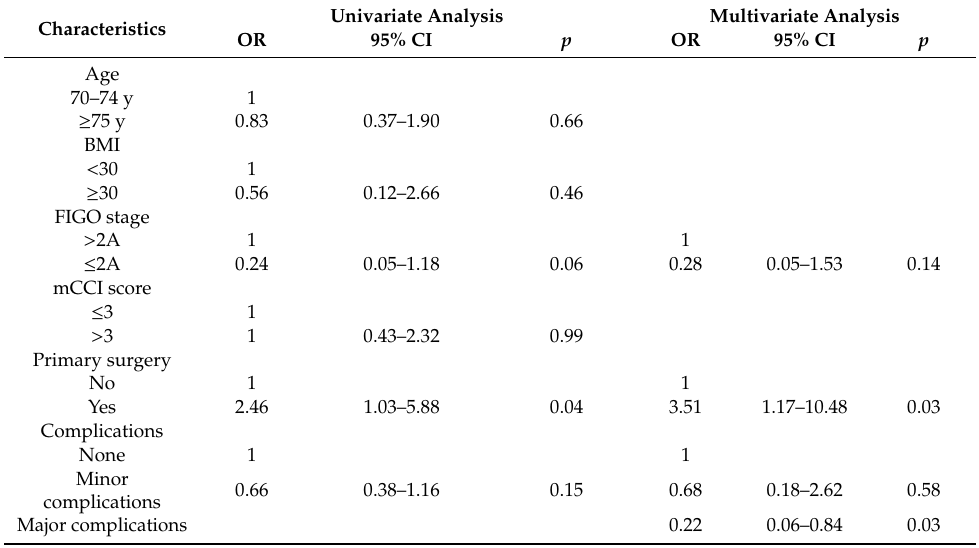
Table A5. Univariate and multivariate analysis of probability of complete